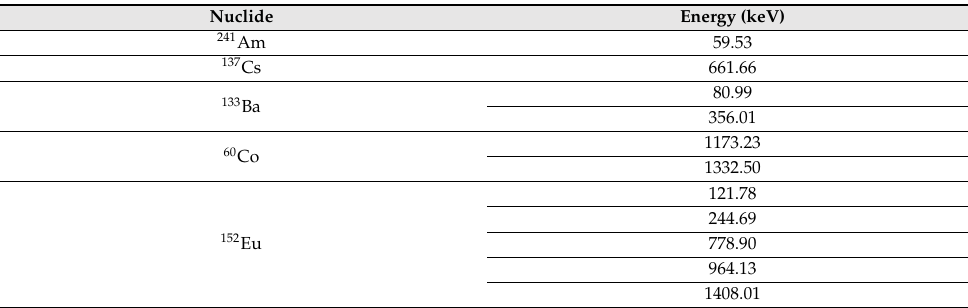
Table 3. Standard radioactive point sources